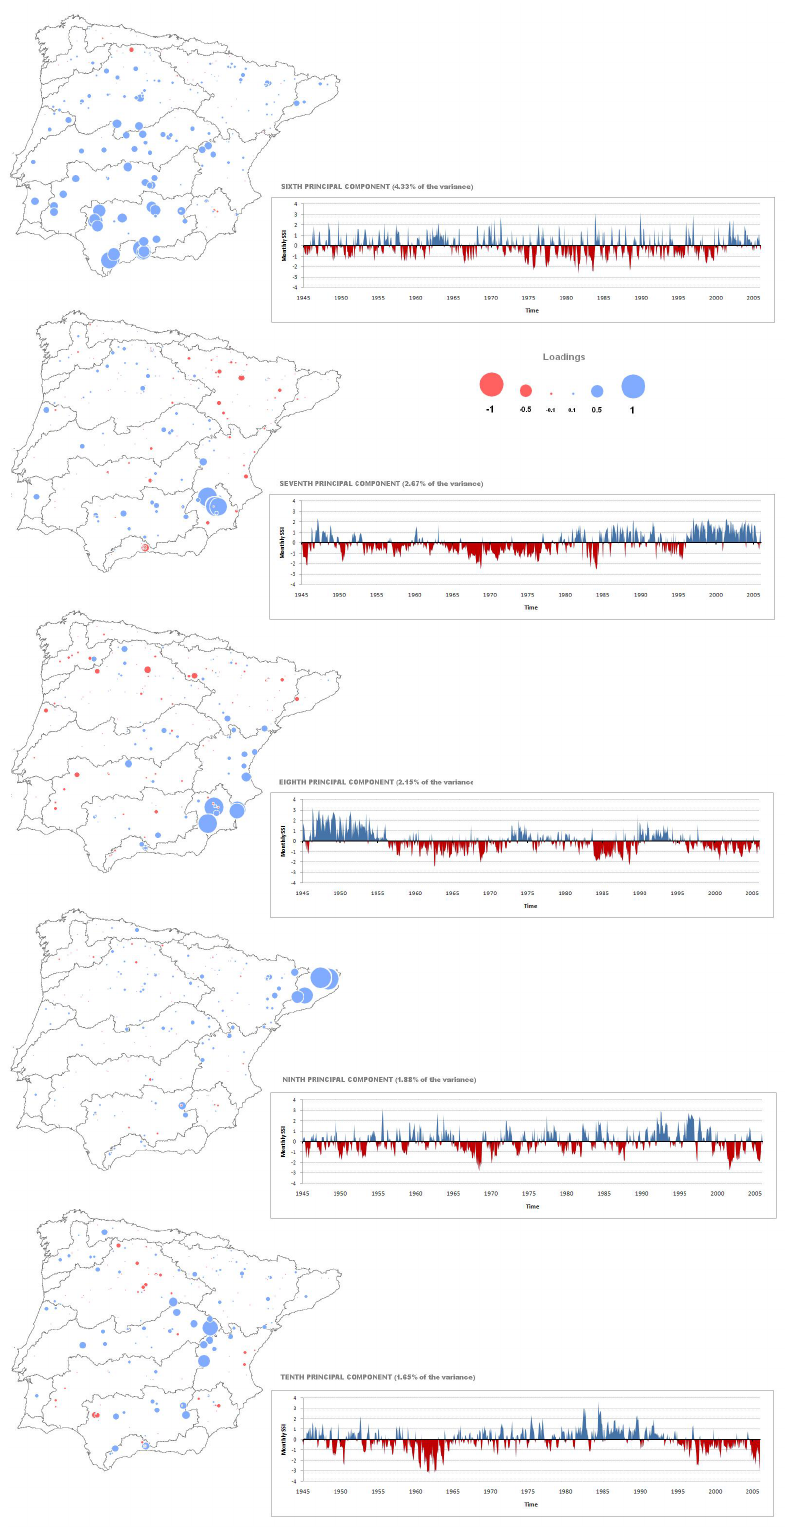
Fig. 5. Spatial distribution of the PCA loadings for the first principal components (6th to 10th), and temporal evolution of the principal components (6th to